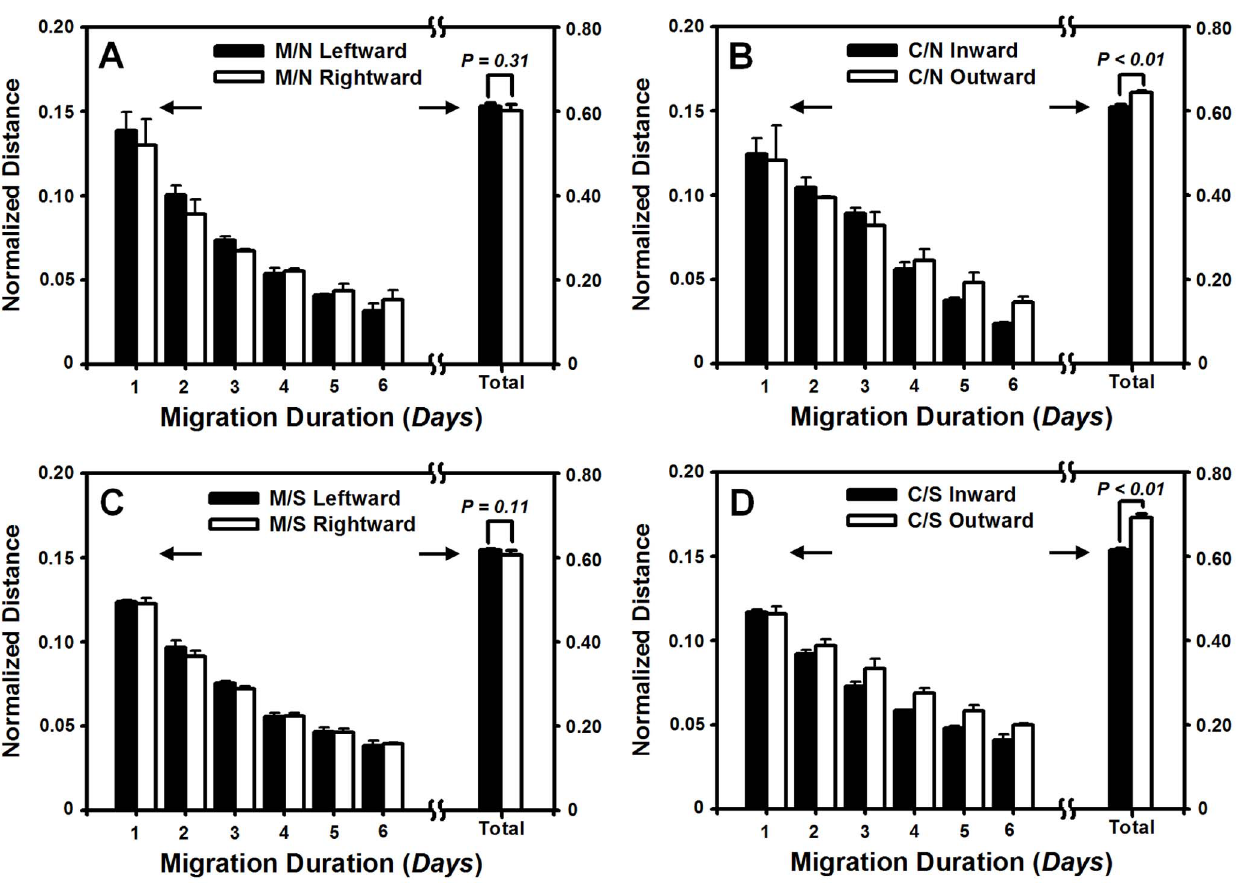
Figure 2. Lateral migration of HaCaT cells on collagen I-coated PDMS membrane in the absence or presence of HF cells and mechanical stretch. ( A, B ) Time course of normalized instantaneous or accumulative distance of monocultured (M/N) ( A ) or cocultured (C/N) ( B ) HaCaT cells in the absence of mechanical stretch. ( C , D ) Time course of normalized instantaneous or accumulative distance of monocultured (M/S) ( C ) or cocultured (C/S) ( D ) HaCaT cells in the presence of mechanical stretch. Data were collected from at least triplets and presented as the mean 6 standard deviation (SD) of migration distance and then normalized by the initial width at t =0 day. P value indicates the level of statistical significance of difference in normalized distances between leftward and rightward migration for M/N and M/S or inward and outward migration for C/N and C/S. Arrows indicate the different scales of the double y-axes for normalized instantaneous and accumulative distances.